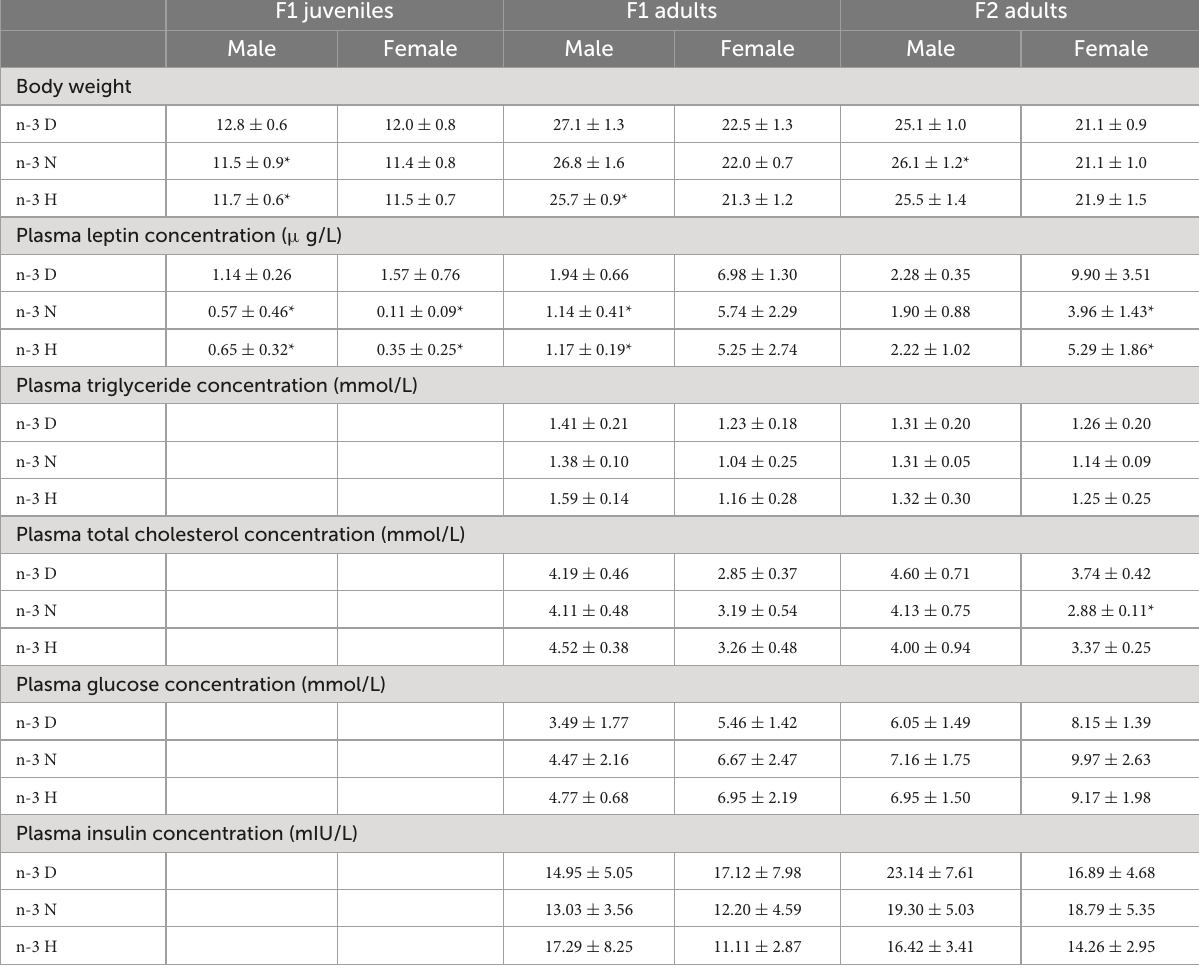
TABLE 4 Effects of paternal n-6: n-3 PUFAs on plasma concentrations of leptin and biochemical parameters in the